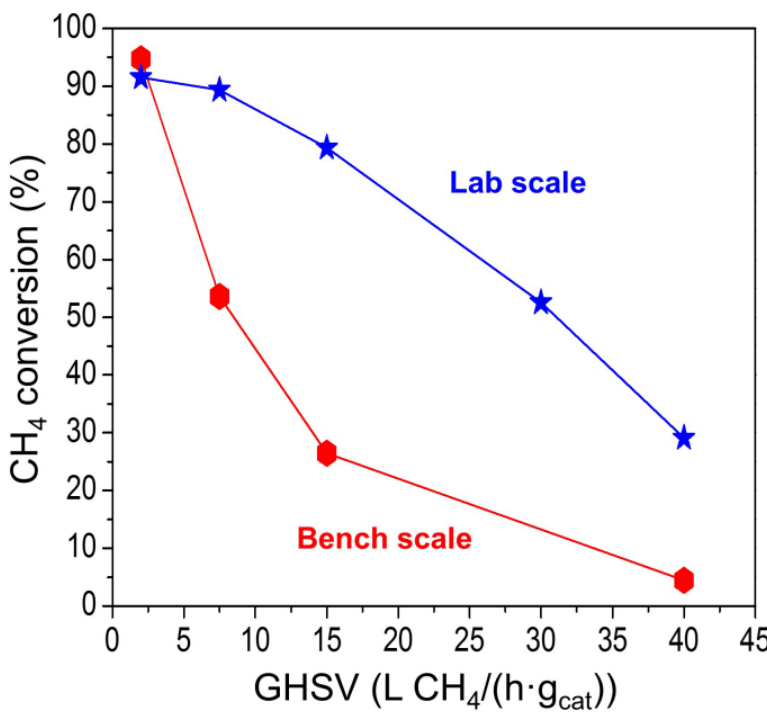
Figure 5. Methane conversion as a function of space velocity in the lab-scale and bench-scale reactors (reaction conditions: steam/methane ratio = 3, feed composition of CH 4 /H 2 O/N 2 = 1/3/1, reaction pressure = 0.6 MPa, and GHSV = 2.0 – 40.0 L CH 4 / ( h·g cat ).